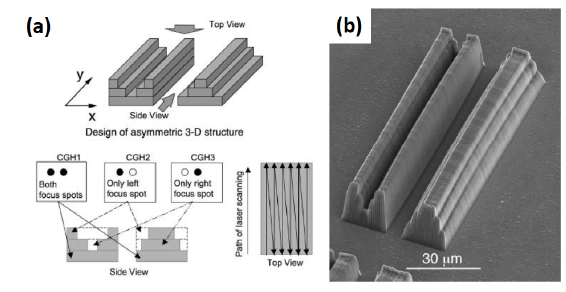
Figure 18: Simultaneous fabrication of asymmetric 3D polymer structures (convex and concave). (a) Design and fabrication pro- tocol. (b) SEM image of structures fabricated by individual control of two focal spots [138]. Reproduced with permission from The Optical Society of America, © 2010 by The Optical Society of America.